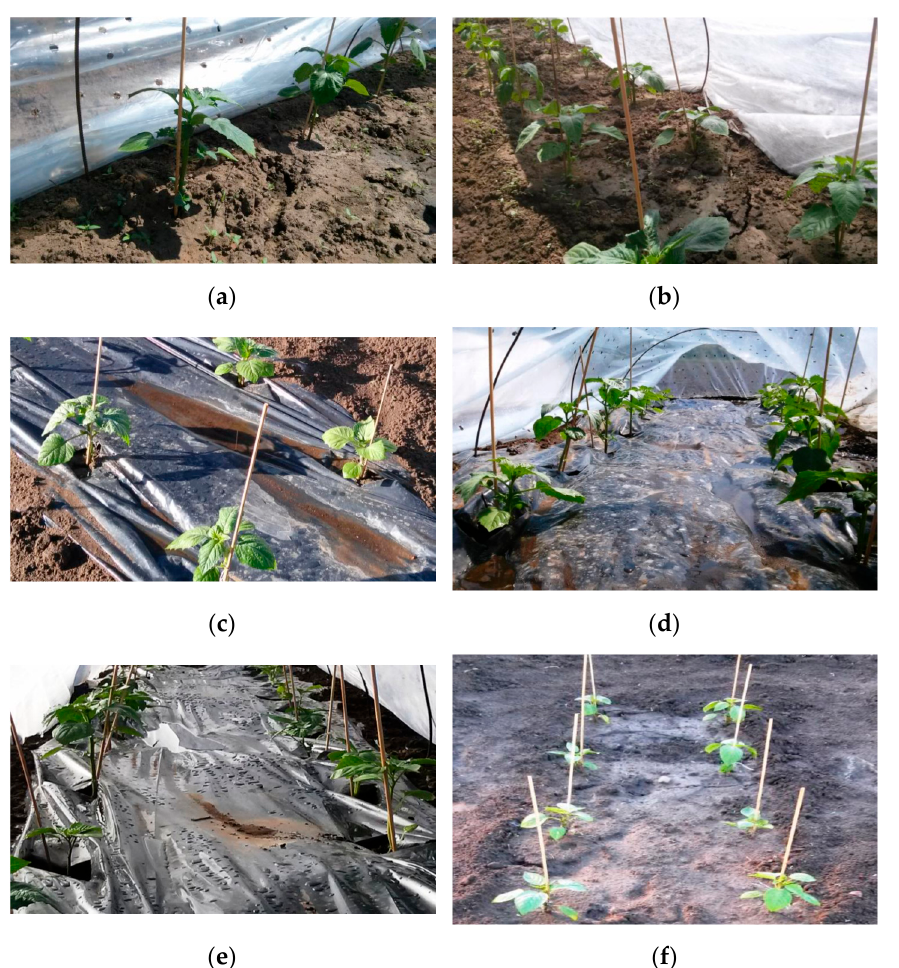
Figure 1. ( a ) Perforated PE film with 100 openings per m 2 for covering field beds (PE), ( b ) non-woven PP fabric with surface density of 17 g m − 2 for covering field beds (PP), ( c ) black PE film with a thickness of 0.05 mm for mulching, ( d ) mulching + PE, ( e ) mulching + PE, ( f ) control treat- ment.